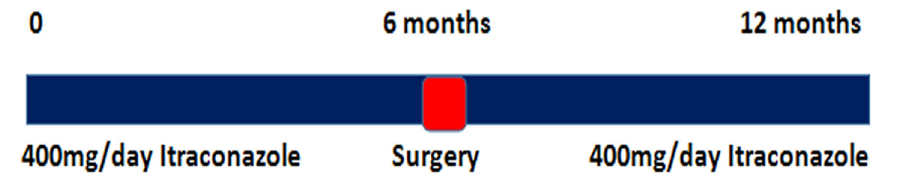
Fig 7. The mycetoma treatment